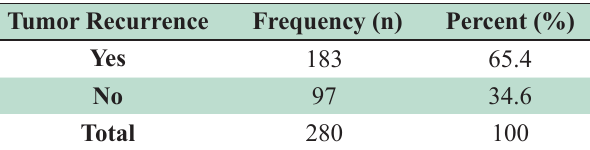
Table-III: Frequency of Recurrence in Patients with NMIBC undergoing TURBT with Post-operative Instillation of BCG n=280.W